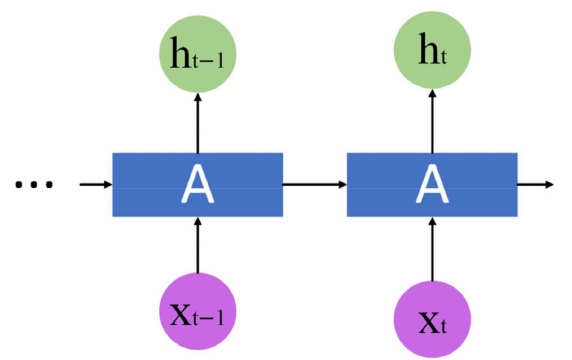
Figure 3. The structure of RNN